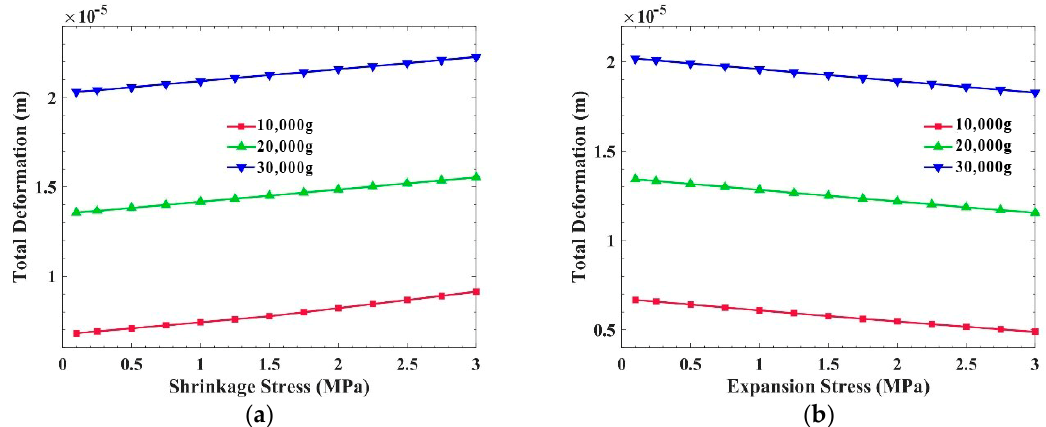
Figure 12. Influence of the different internal stresses of the potting adhesive on the total deformation of the metal frame: ( a ) Shrinkage stress; ( b ) Expansion stress.